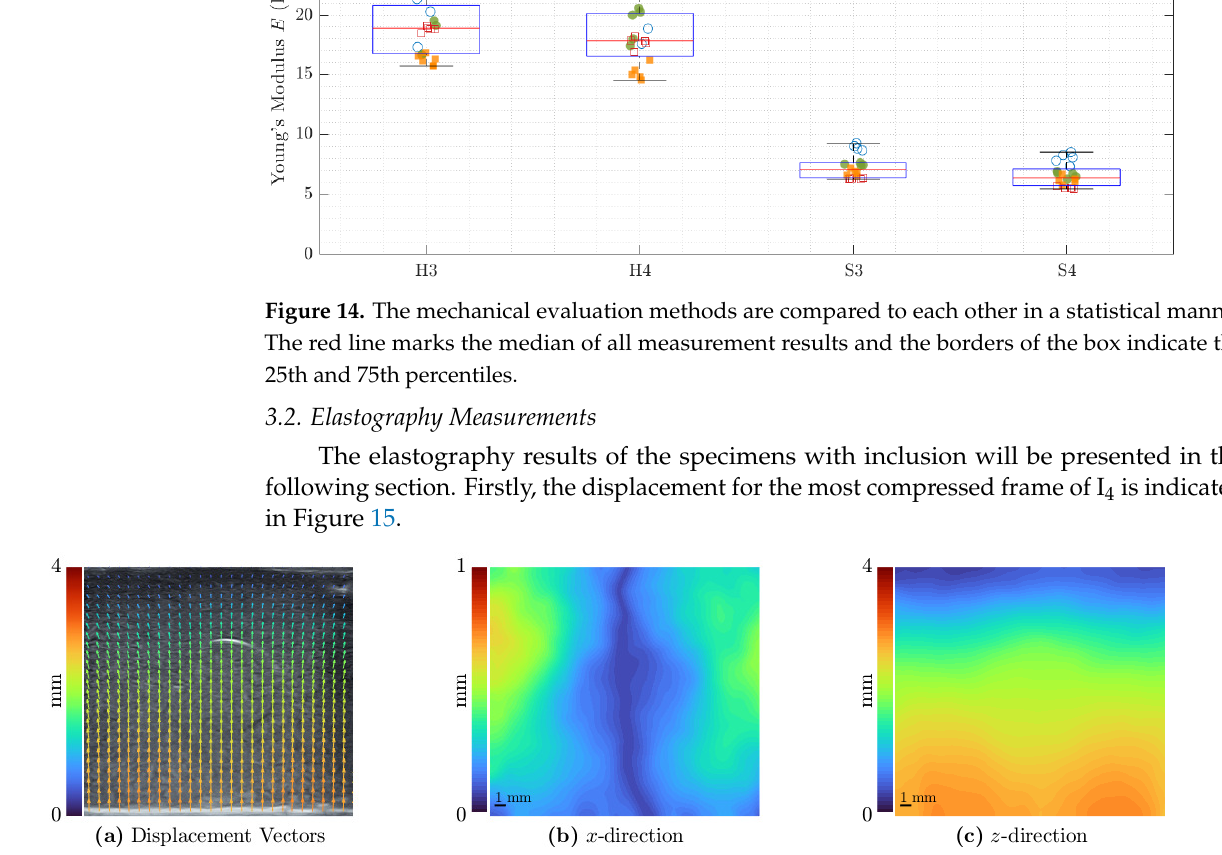
Figure 15. The vectorial displacement in the specimen is shown as an overlay on the ultrasound image in panel ( a ). The absolute value of the displacement in x - and z -direction is displayed in panel ( b , c ), respectively. An indicator of 1mm is added in the lower left corner. The whole displayed region measures 25mm × 25mm.